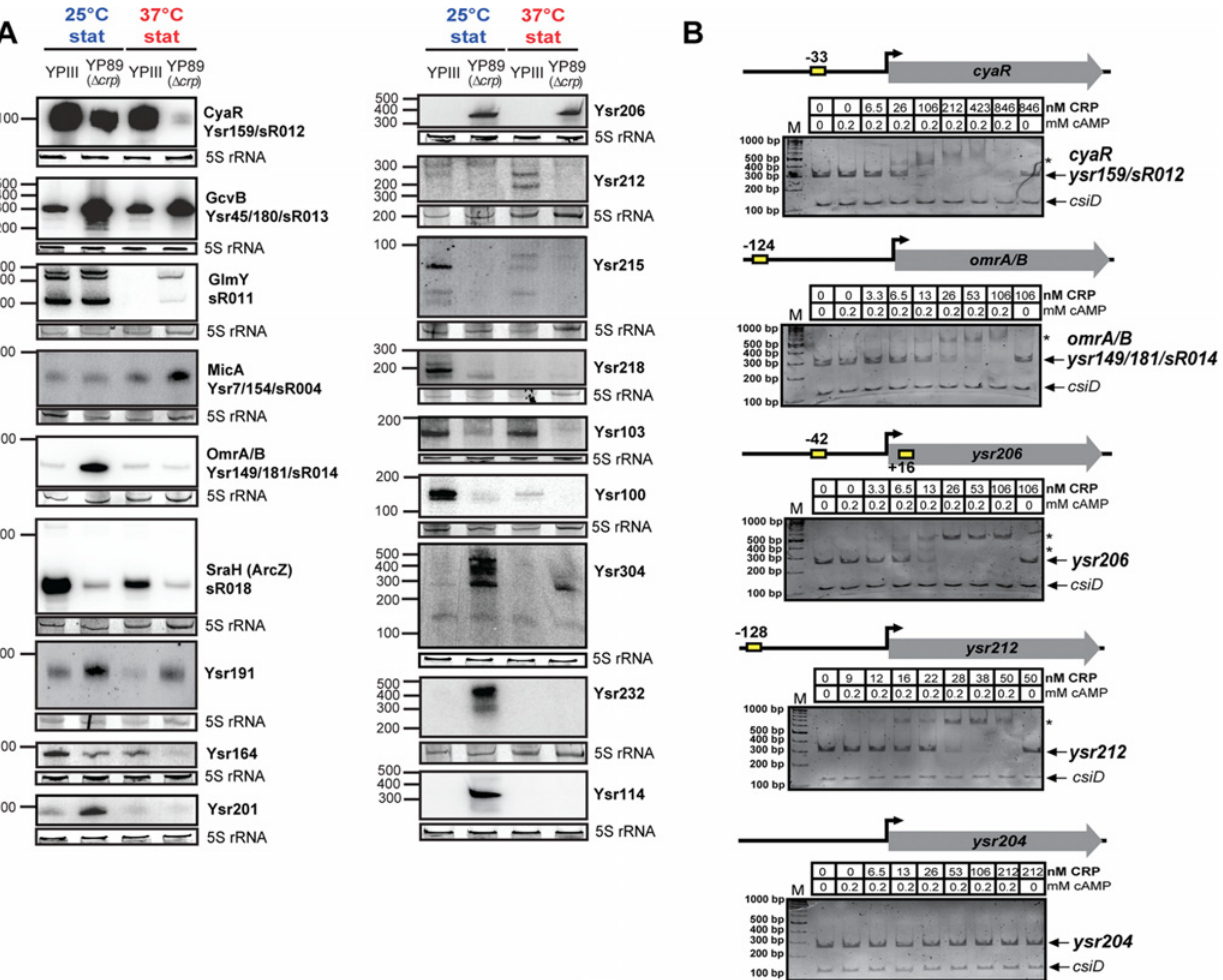
Fig 5. CRP-dependent non-coding RNAs of Y. pseudotuberculosis . (A) Northern blot analyses of selected CRP-regulated non-coding RNAs. RNA samples were prepared from YPIII and YP89 (YPIII Δ crp ) bacteria grown to stationary growth phase (stat) at 25°C and 37°C. 5S rRNA served as loading control. The size marker (nt) is indicated. (B) Interaction of CRP with the regulatory regions of selected CRP-regulated sRNA genes. Individual DNA fragments with the predicted CRP-binding site(s) (yellow boxes; S3 Dataset) used for electrophoretic mobility shift assays are illustrated. An individual sRNA promoter fragment ( ysr204 ) for which no CRP-binding site was predicted was included as negative control. Respective DNA fragments were incubated with increasing concentrations of CRP and 0.2 mM cAMP. As a negative control, cAMP was omitted in samples with the highest CRP concentration (right lane). The CRP-DNA complexes were separated on 4% polyacrylamide gels. The position of specific higher molecular weight complexes is marked with an asterisk. A molecular weight standard (M) was loaded, and the corresponding molecular weights are indicated. A csiD PCR fragment amplified from E . coli served as an internal negative